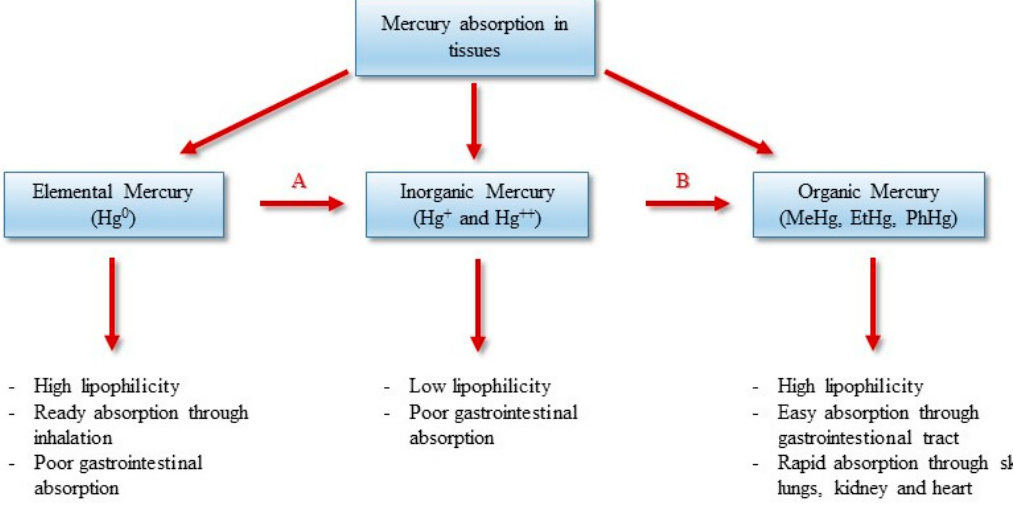
Figure 1. Bioavailabilty and toxic effects of mercury and its compounds. A: Oxidation in air, and enzymatically in red blood cells and tissues; B: Biomethylation by sulfate-reducing bacteria.